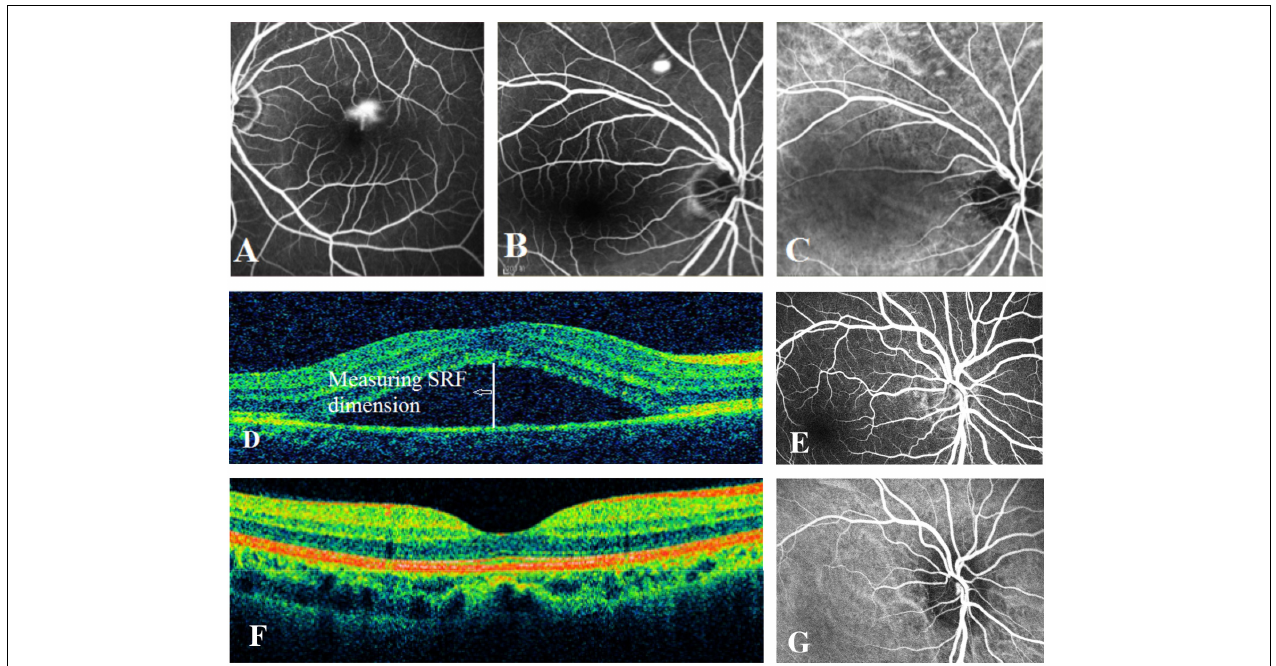
FIGURE 1 | Examples of fundus fluorescein angiography (FFA), indocyanine green (ICG) angiography, and spectral-domain optical coherence tomography (SD-OCT) in individuals with acute CSC and controls. (A) The left eye of an individual with a typical smokestack leakage point on FFA. (B) The right eye of an individual with a typical inkblot-like leakage point on FFA. (C) The ICGA image of the same individual as in panel (B) , showing choroidal vascular dilatation. (D) An obvious central subretinal fluid (SRF) between retinal neurepithelium layer and retinal pigment epithelium layer on OCT. (E) The FFA image of one of the controls showing no leakage point. (F) The OCT image of one of the controls showing no subretinal fluid. (G) The normal ICGA image of one of the controls. TABLE 1 | Association results for 12 AMD-known SNPs with nominal significance in acute CSC in Han Chinese population.